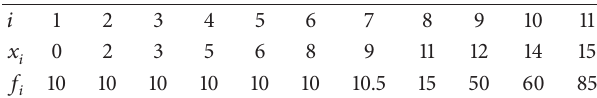
Table 3: Akima’s dataset given in [27].